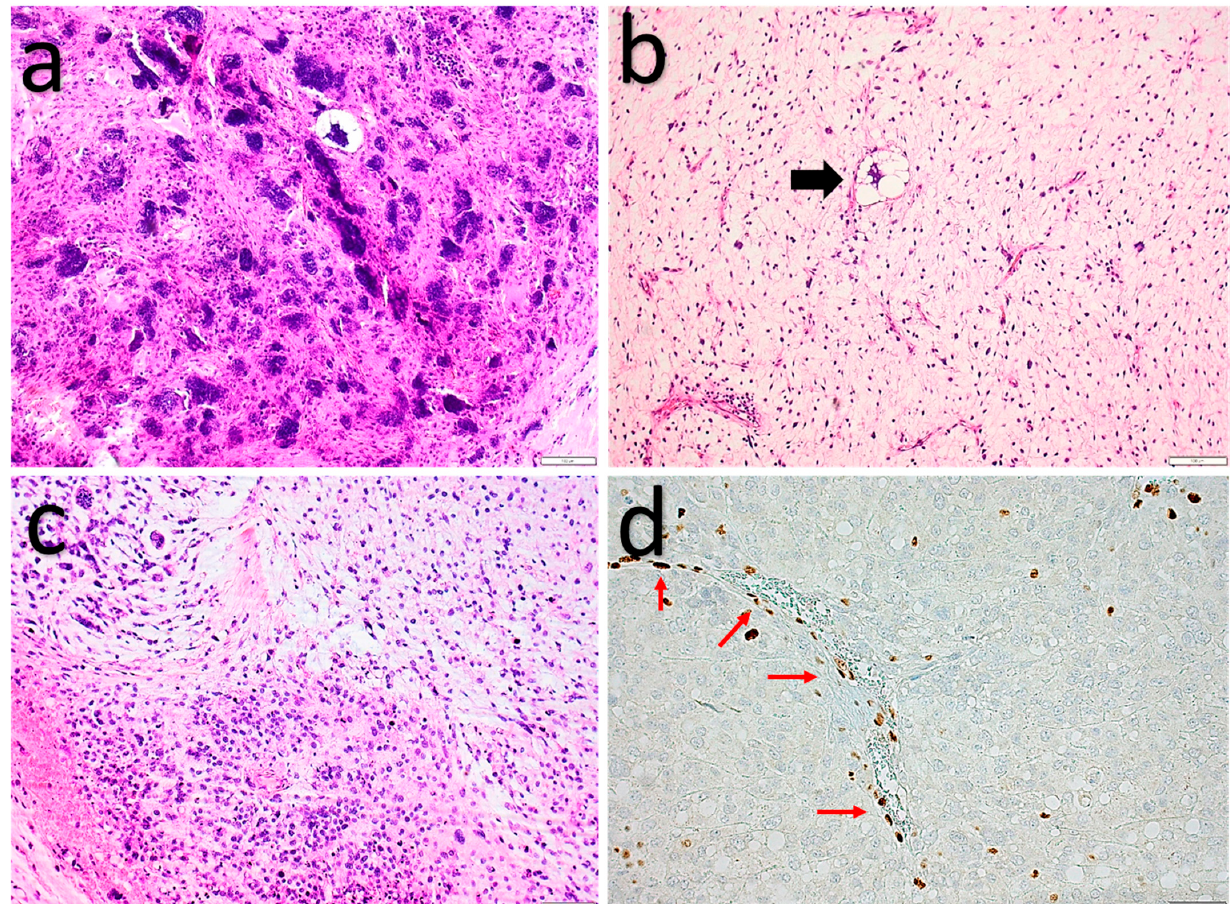
Figure 5. Pleomorphic liposarcoma. ( a ) High-grade pleomorphic sarcoma morphology with pleomorphic lipoblasts (arrow). ( b ) Myxofibrosarcoma-like morphology with pleomorphic lipoblast (arrow). ( c ) High-grade epithelioid sarcoma morphology. ( d ) Loss of nuclear Rb expression in the tumor cells and intact nuclear Rb expression in the endothelial cells (red arrows).